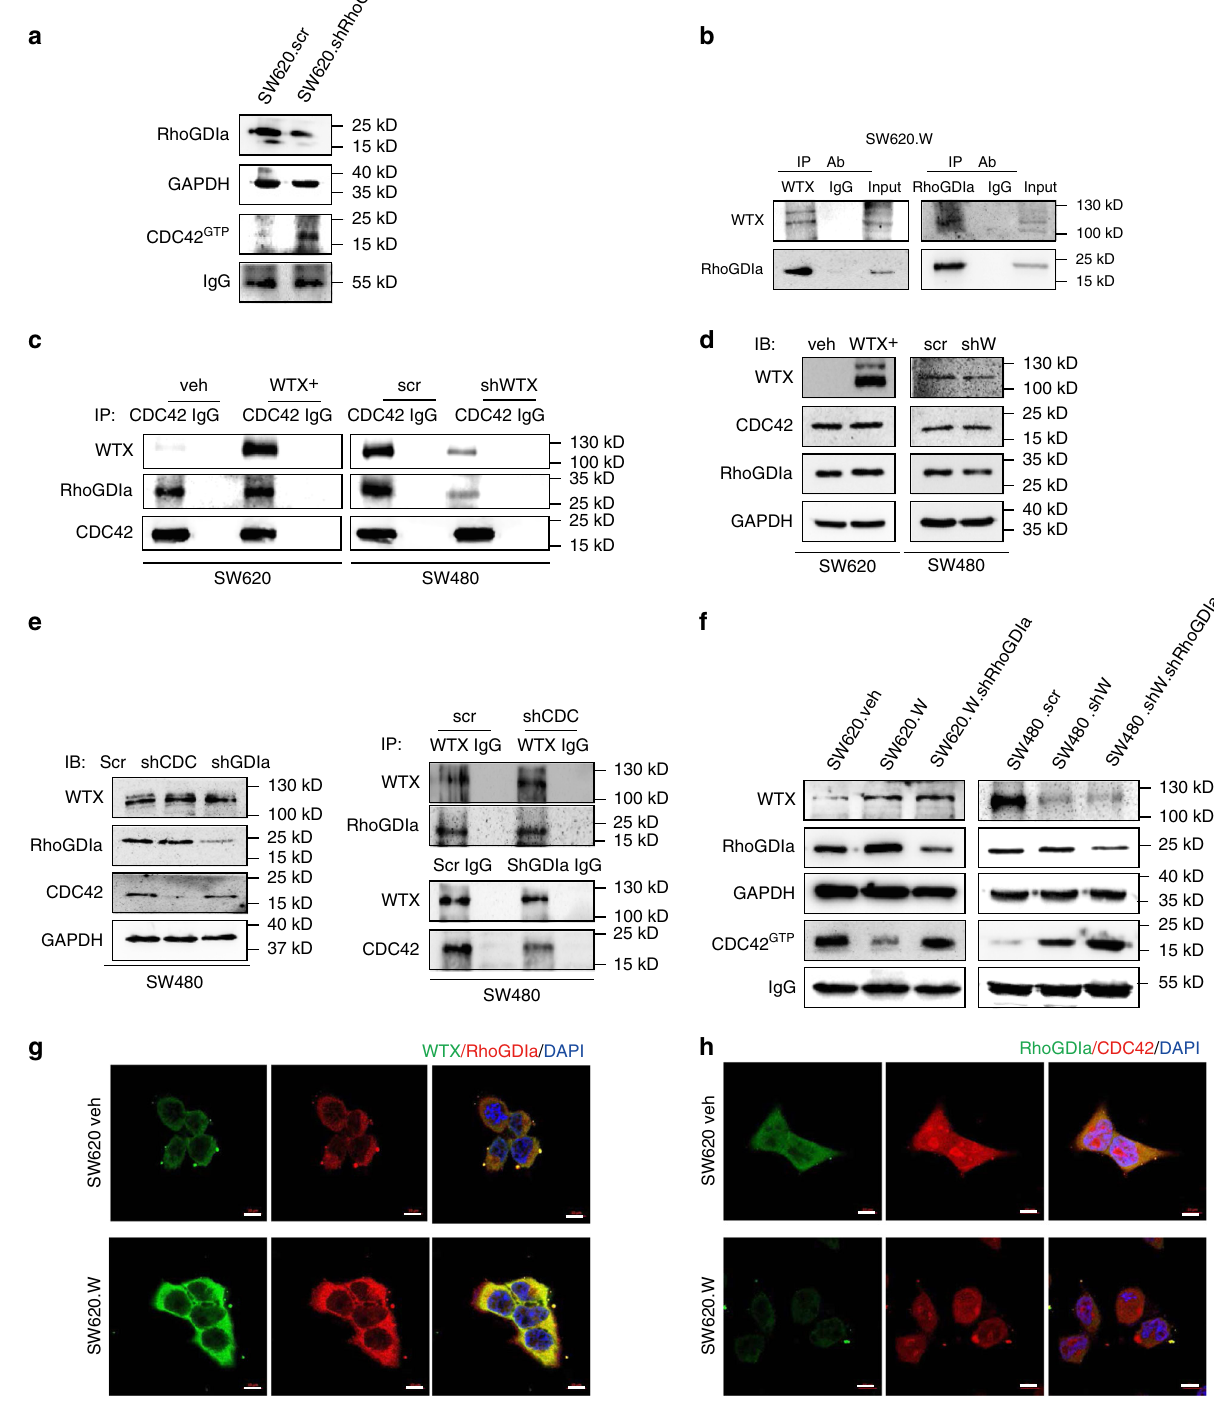
Fig. 3 WTX inhibits the activation of CDC42 through stabilizing the RhoGDI α -CDC42 binding. a IB analyzes the expression changing of CDC42 GTP in the indicated cells. b CO-IP analyzes the interaction between WTX and RhoGDIa in SW620.W cells. c CO-IP analyzes the interactions between RhoGDIa and CDC42 in the indicated cells. d IB analyzes RhoGDIa and CDC42 expression changes in the indicated cells. e IB analyzes WTX, RhoGDIa and CDC42 expression changes in indicated cells; CO-IP analyzes the interactions between WTX and RhoGDIa, or WTX and CDC42 in indicated cells. f IB analyzes of WTX, RhoGDIa and CDC42 GTP expression changes in indicated cells. g IF staining analyzes the colocation of WTX and RhoGDIa in WTX overexpression cells. Scale bars, 10 μ m. h IF staining analyzes the colocation of RhoGDIa and CDC42 in WTX overexpression cells. Scale bars, 10 μ